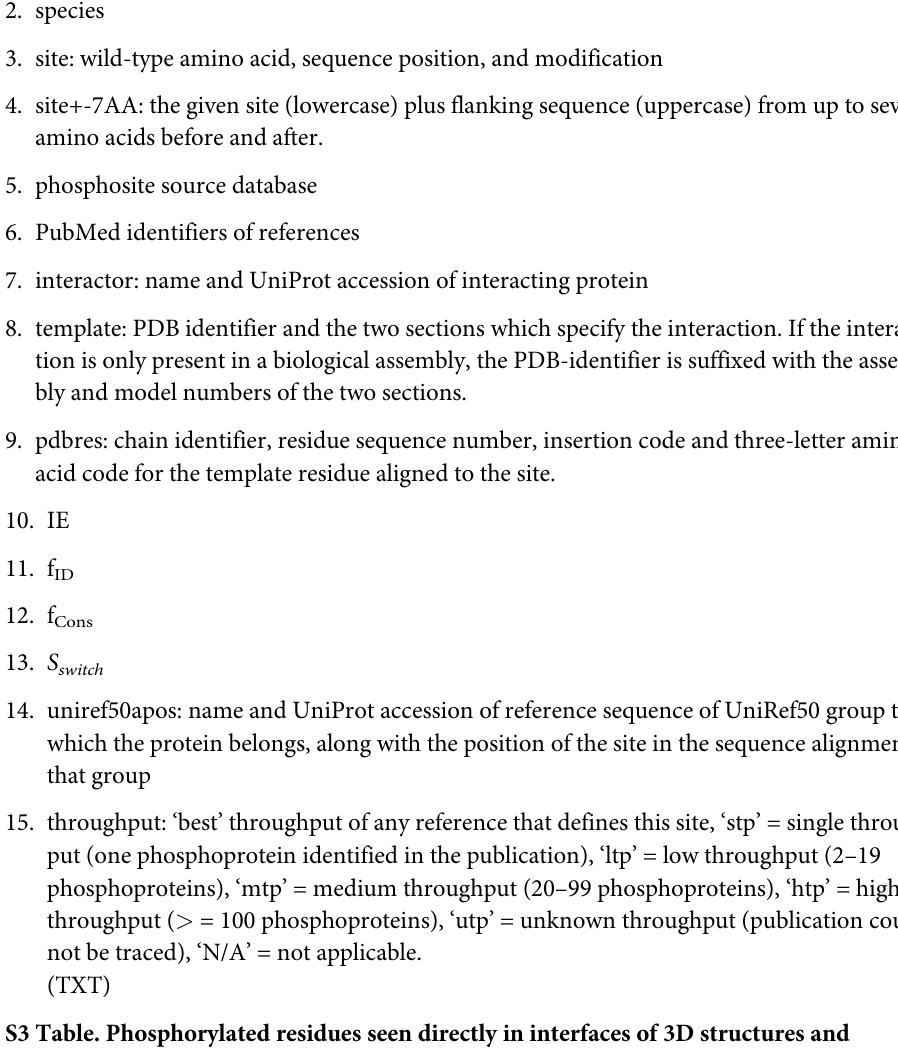
S3 Table. Phosphorylated residues seen directly in interfaces of 3D structures and their unphosphorylated equivalents in homologues of known structure. (Data